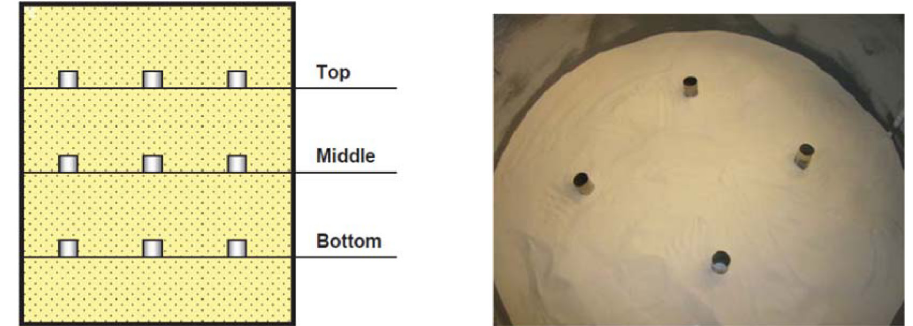
Fig. 2. Molds used to control the sand relative density